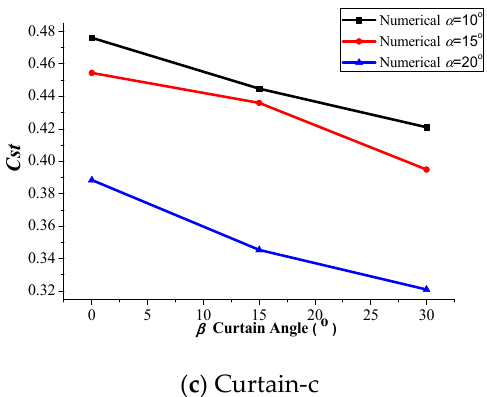
Figure 10. Static torque coefficients of ( a ) Curtain-a, ( b ) Curtain-b and ( c ) Curtain-c ( θ = 45°).